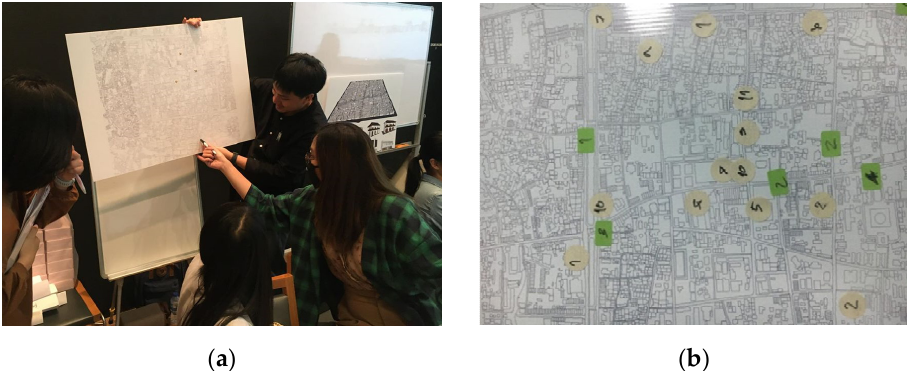
Figure 5. ( a ): Focus Group discussion process (Author). ( b ) Mapping the significant places on Chiang Mai Old City Map (Author).